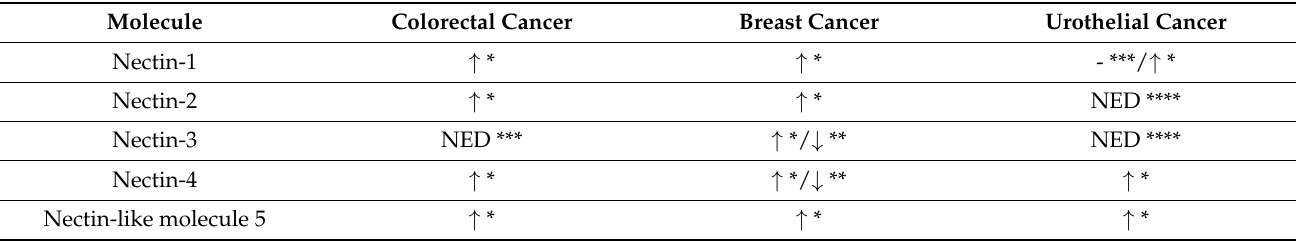
Table 2. Expression of Nectins and Necls in selected